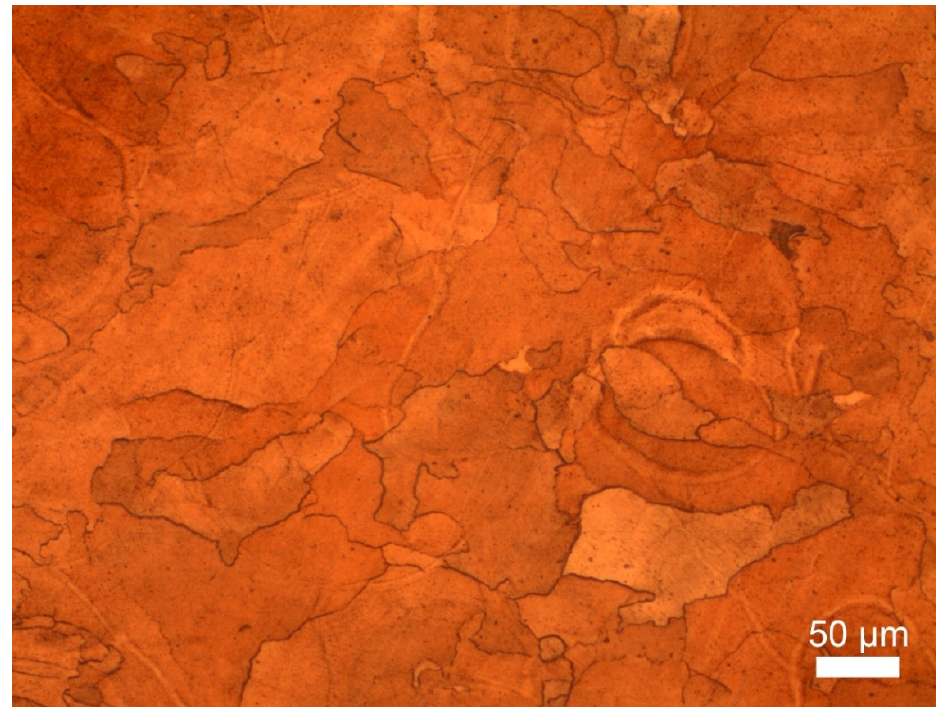
Figure 3. Etched microstructure of the most dense sample fabricated by the optimal regime.